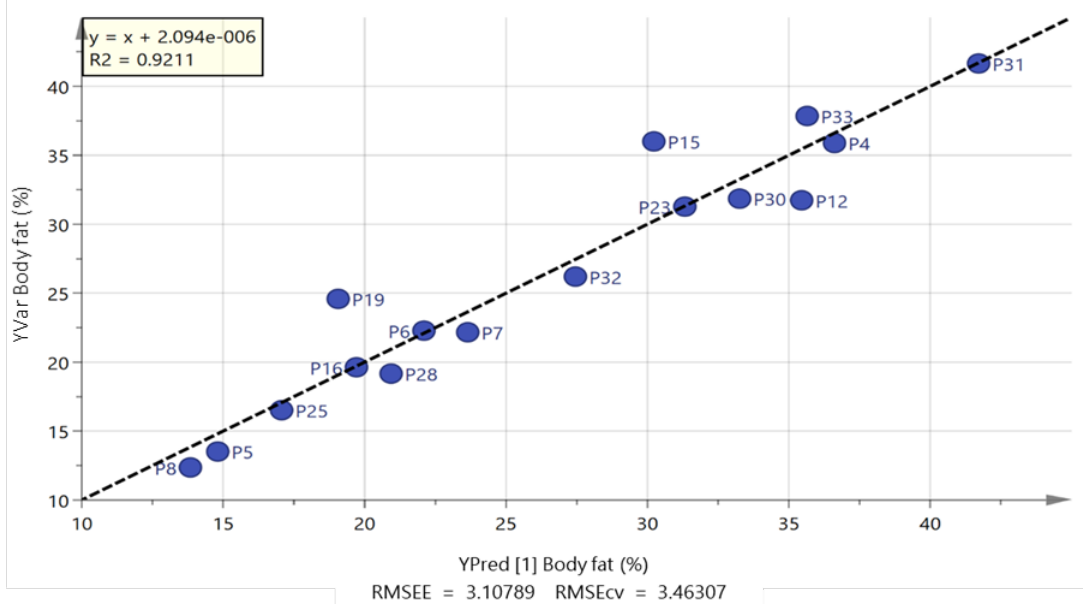
Figure 3. OPLS plot of predicted against actual body fat percentage based on five free fatty acids for South Asian men (palmitate, stearate, linoleate, eicosatetraenoic acid and docosahexaenoic acid).